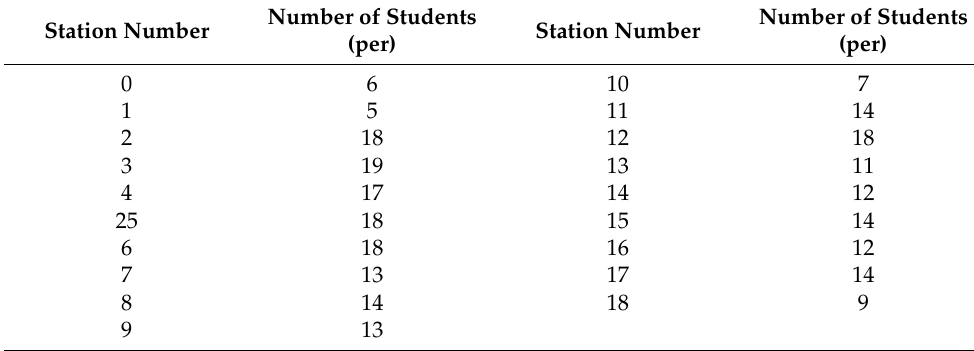
Table 3. The number of students at the transfer station.